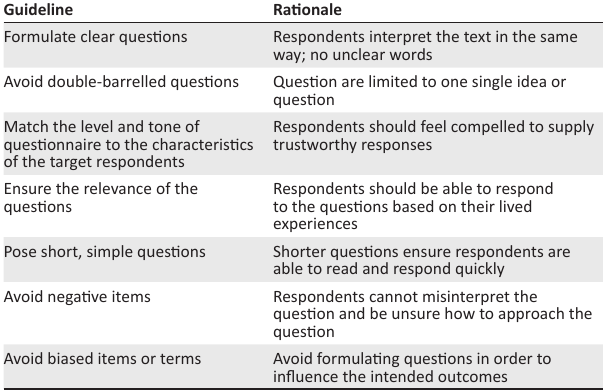
TABLE 4: Seven guidelines to formulate questions.